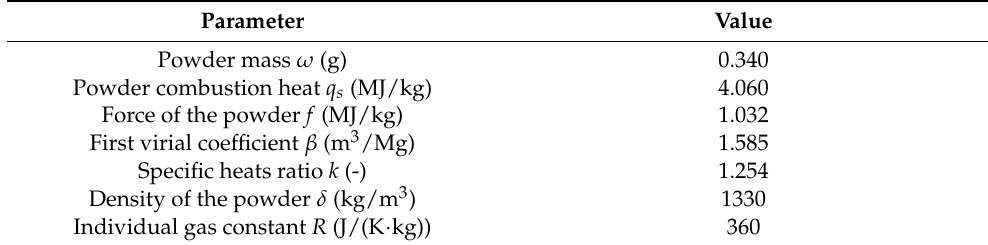
Table 2. Parameters of the powder in cartridge.